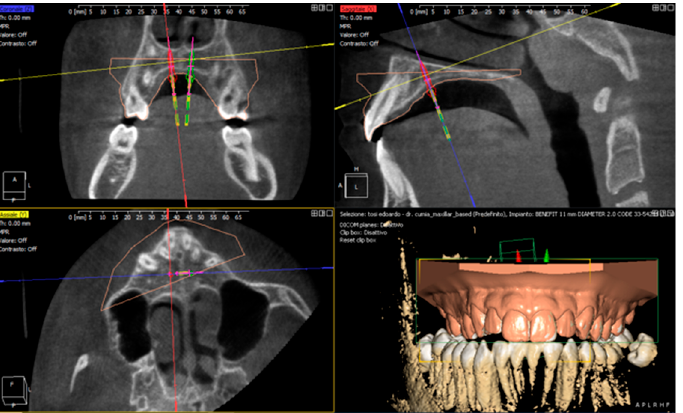
Figure 5. Three dimensional (3D) planning of a surgical guide for the placement of orthodontic miniscrews.